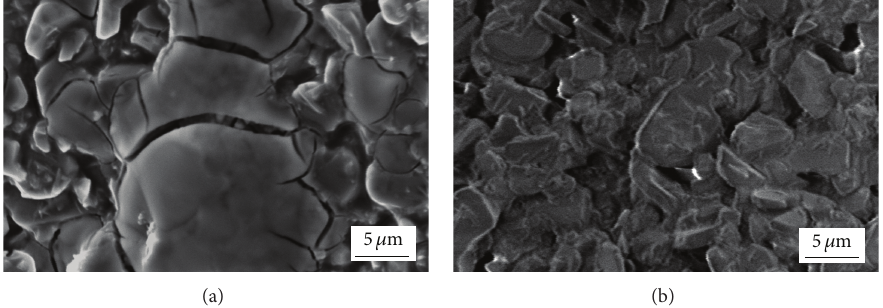
Figure 6: SEM micrographs of samples with 20wt% Ni loading: (a) chloride precursor for Ni on the foam surface and (b) Ni on the foam surface, obtained after reduction of chloride precursor at 633